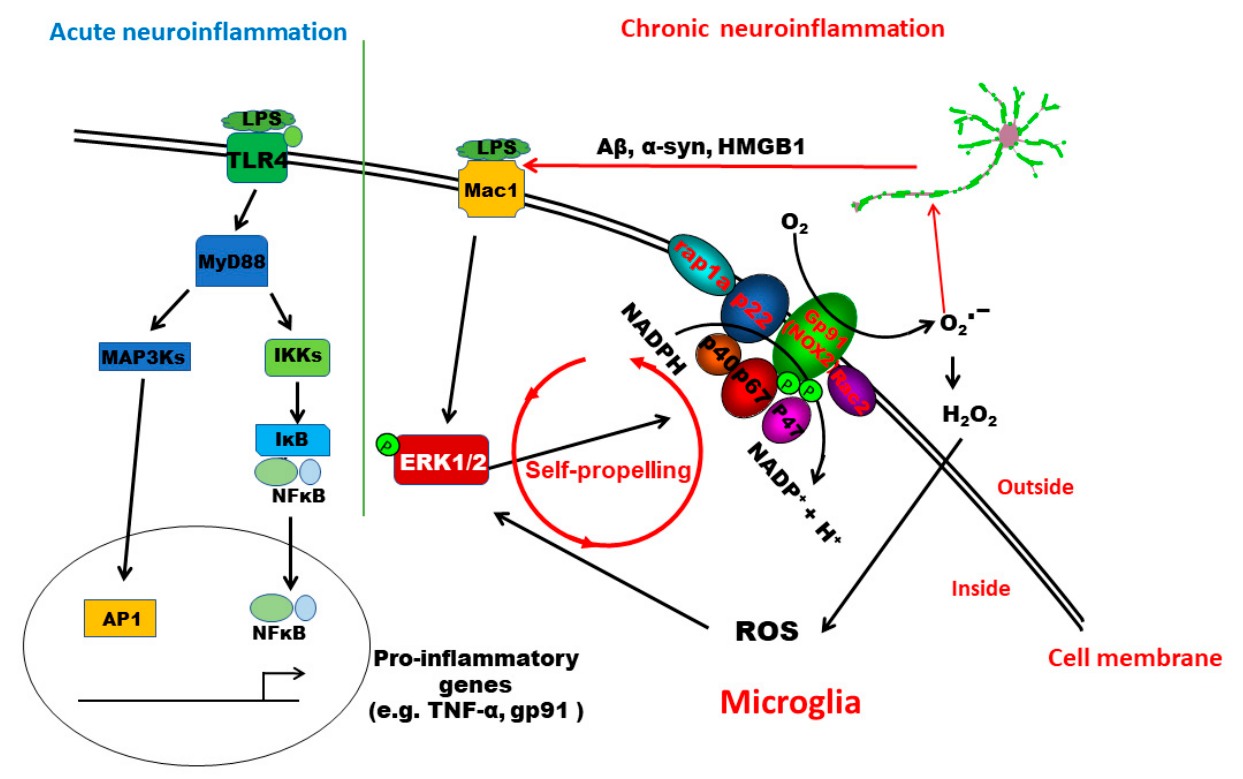
Figure 8. Schematic drawing depicting possible signaling pathways mediating LPS-elicited acute and chronic neuroinflammation. The TLR4 signaling pathway plays a critical role in initiating LPS- elicited acute neuroinflammation but may not be sufficient to maintain chronic neuroinflammation. This study revealed that the activation of the MAC1-NOX2-ERK1/2 pathway is essential in the initiation/maintenance of chronic neuroinflammation and in triggering the resultant neuronal loss. Further evidence indicates that the coupling of MAC1 and its downstream effector NOX2 is essential in maintaining sustained reactive microgliosis and chronic neuroinflammation. During the chronic neuroinflammatory stage, continuing activation of MAC1 by DAMPs primarily released from dam- aged/dying neurons triggers long-lasting ERK1/2 phosphorylation, which further activates NOX2. The MAC1-NOX2 axis activation in microglia produces superoxide and ROS to cause oxidative stress, forming a vicious feedforward cycle to maintain the reactive microgliosis. Continuing operation of this vicious cycle serves as a critical driving force to sustain low-grade neuroinflammation and drive